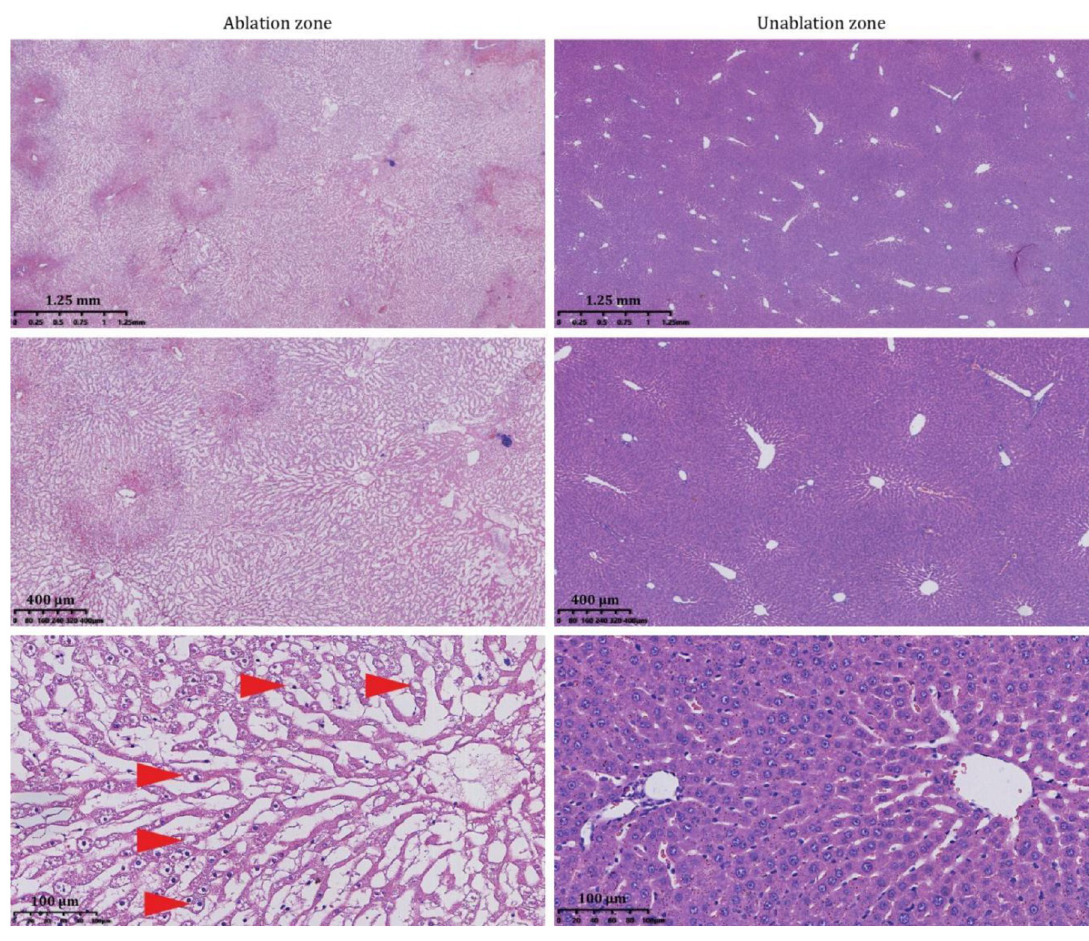
Fig 3. HE-stained sections of nsPEF-ablated and unablated regions of normal rat livers(n = 6). The two electrodes of nsPEFs were inserted into the two sides of the liver lobe of anesthetized healthy rats at a distance of 1 cm. Pulse parameters were set as field intensity of 10 kV/cm, frequency of 2 Hz, pulse number of 800 times, pulse duration of 300 ns. At 24 h after ablation, HE staining was performed on the melted tissue. The light-colored areas in the image on the left are ablated areas, and the unablated areas are in the image on the right. As the red arrowheads show, at 24 h after nsPEF ablation, most hepatocytes were large and swollen, with pale eosinophilic cytoplasm, nucleolysis and necrosis. nsPEFs: nanosecond pulsed electric